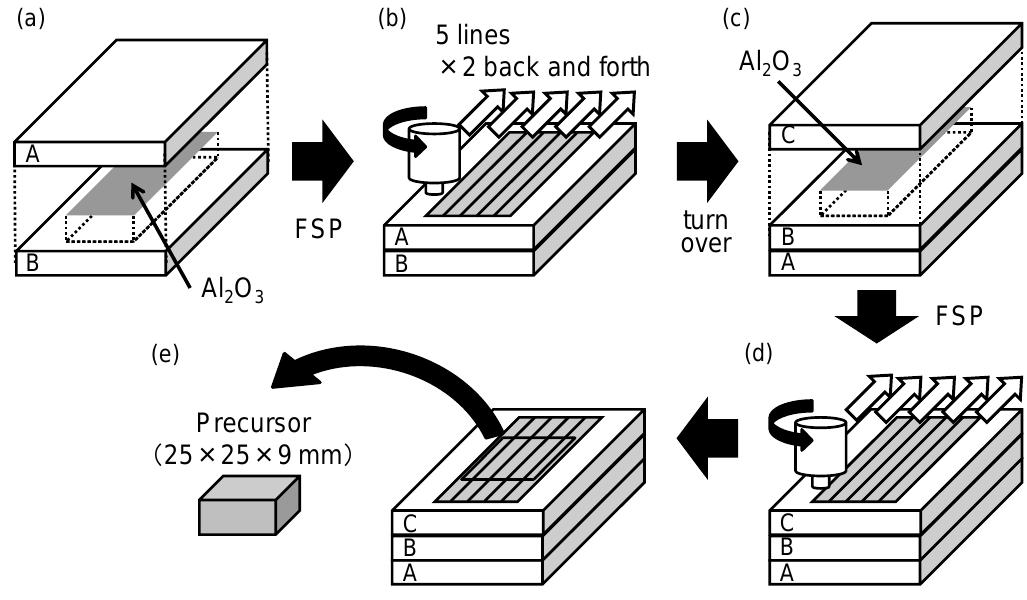
Figure 7. Schematic illustration of the fabrication process of the precursor of ADC12 foam from ADC12 Al alloy die-casting plates by FSP route.